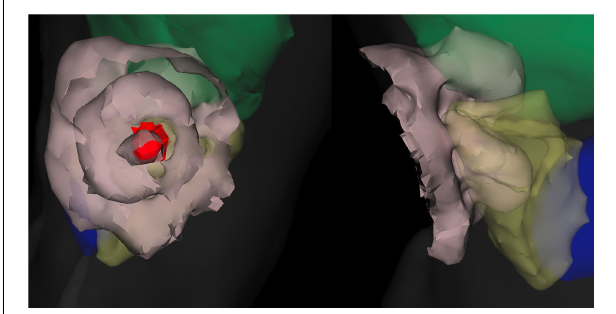
FIGURE 7 | Fluence field for “good” plan depicted as isofluence contours (beige surfaces, spaced in factors of 10). The organs visible are liver (green), lung (yellow), and heart (blue) along with the outer surface (faint gray). Both views show the same case from different perspectives. The tumor is the interior red surface, with the embedded line source shown in a darker red. The impact of optical-property differences between the organs is visible from the lobed appearance of the outer contour